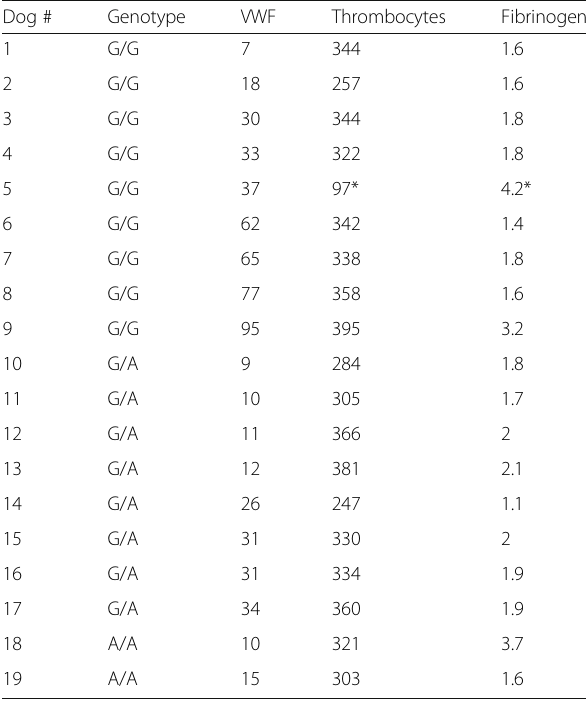
Table 1 Individual determination of genotype and coagulation profile in the Dutch Shepherd